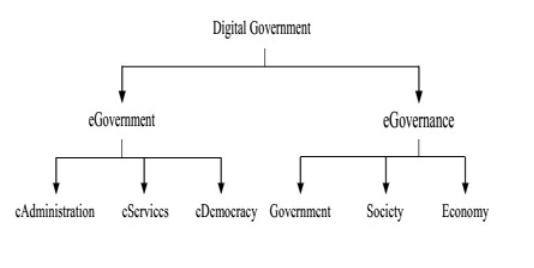
Figure 1: Typology of digital government. Adopted from (Schellong,